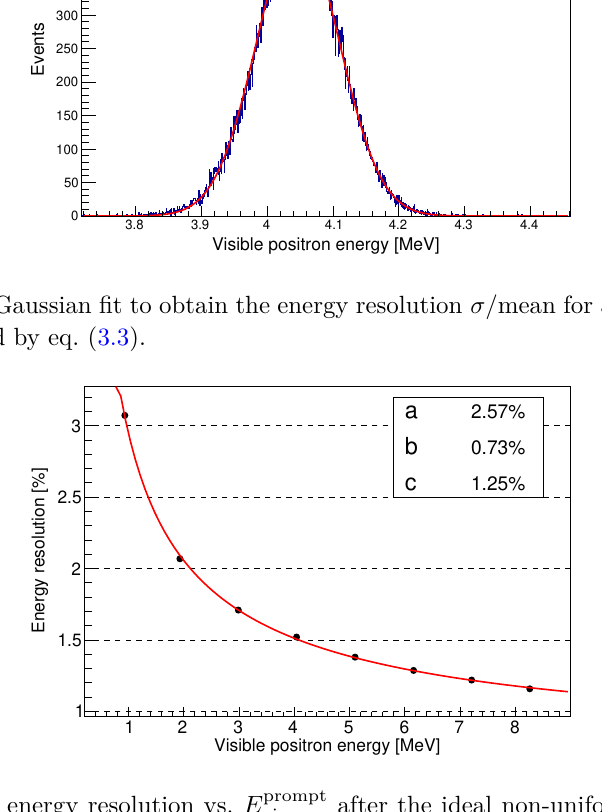
after the ideal non-uniformity correction (un- Figure 10 . Positron energy resolution vs. E prompt vis certainties are smaller than the markers). The red line shows the fit using eq.